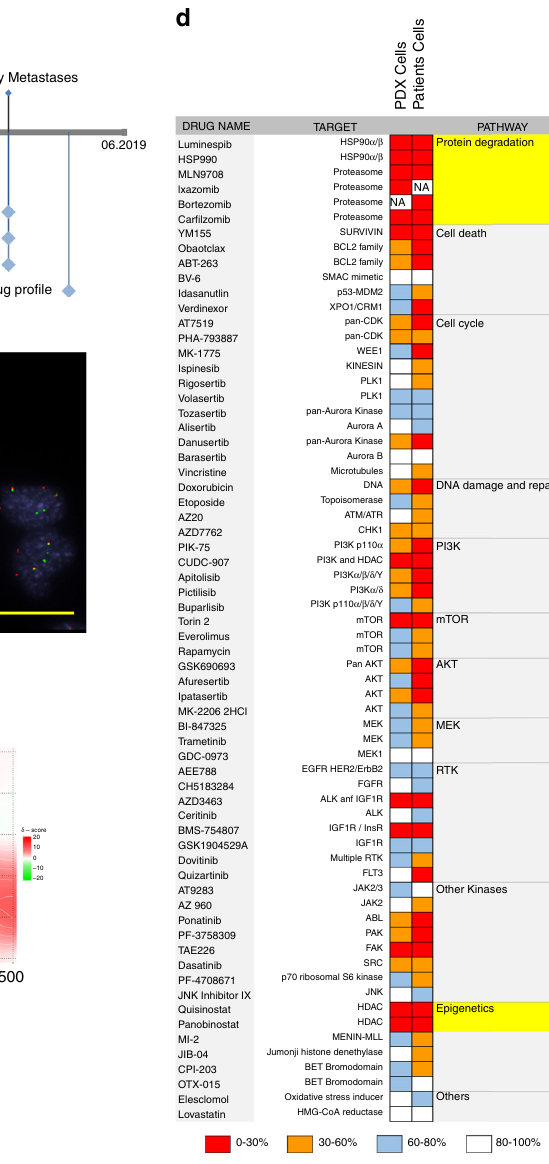
Fig. 5 Direct culture of RMS patient cells for drug pro fi ling and therapy guidance. a Scheme depicting the clinical course of patient RMS-ZH002. b Bright- fi eld image of cells isolated from the lymph node biopsy of patient RMS-ZH002. Scale bar 400 μ m. The displayed image is representative of n = 1 individual cell isolation. c Fluorescence in situ hybridization detection of the FOXO1 gene using probes binding to genomic sites N- (red) and C-terminal (green) of the gene. The displayed image is representative of n = 1 fl uorescence in situ hybridization experiment. d Heat map depicting the activity of indicated agents used at a fi nal concentration of 500 nM on cells isolated from PDX RMS-ZH002 and on cells isolated from the lymph node biopsy. Each color in the heat map indicates the percentage of remaining cell viability after treatment relative to vehicle control: 0 – 30% (red), 30 – 60% (orange), 60 – 79% (light blue) and >79% (white). e , left panel Heat map depicting effect of panobinostat and bortezomib alone and in combinations on viability of RMS-ZH002 patient cells isolated from the lymph node biopsy (Mean; n = 2 biological replicates). Clinically applicable concentrations of the two drugs are framed with a green box. Right panel, Heat map depicting synergism between panobinostat and bortezomib using zero interaction potency model analysis. Source data are provided as source data fi